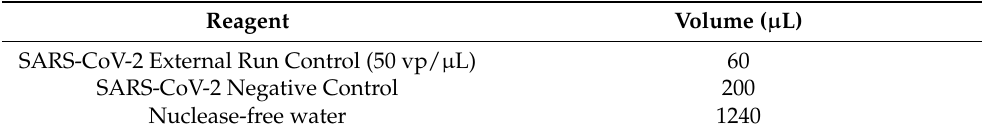
Figure 1. Correct loading of the metal oven rack for heat ‐ inactivation.